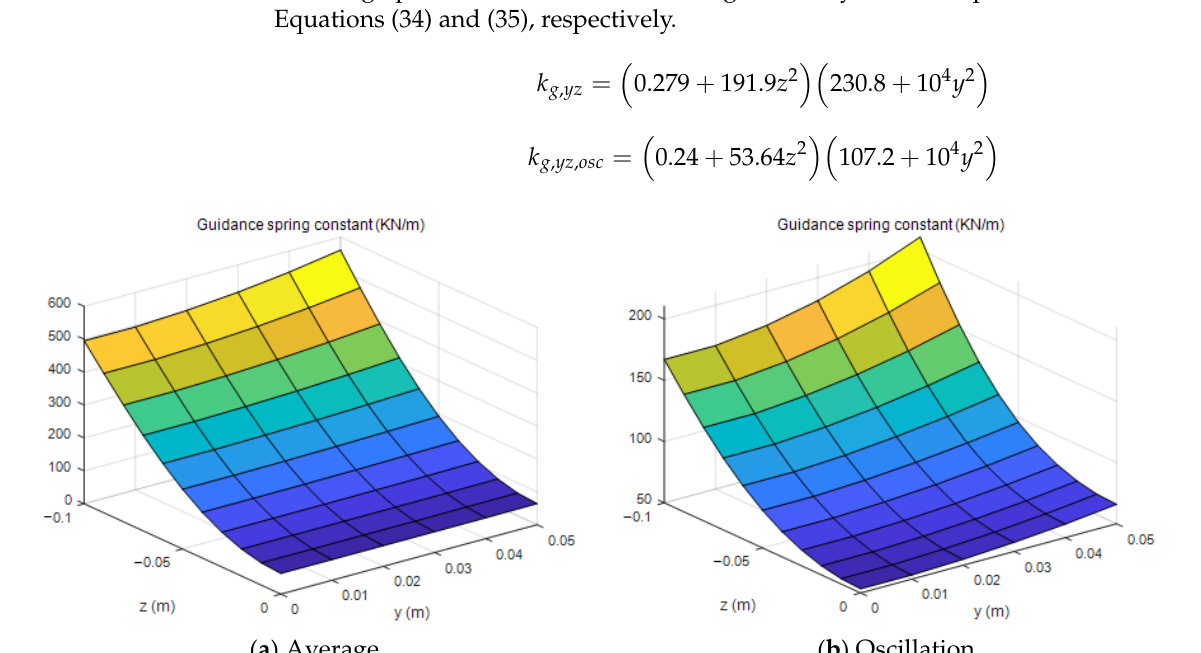
Figure 14. Guidance stiffness with respect to the vertical and lateral positions.